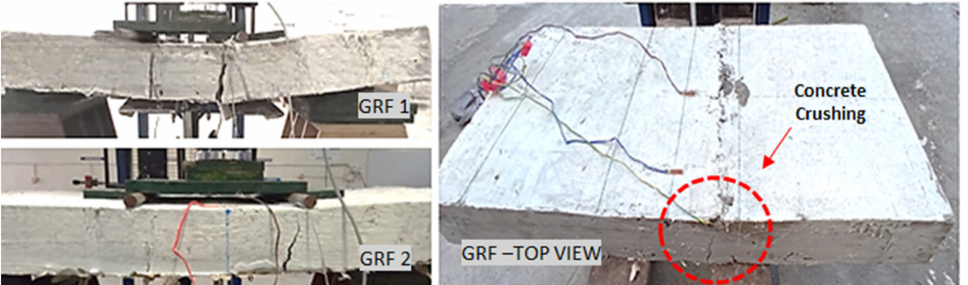
Figure 5. Crack pattern and failure mode of GRC slab.